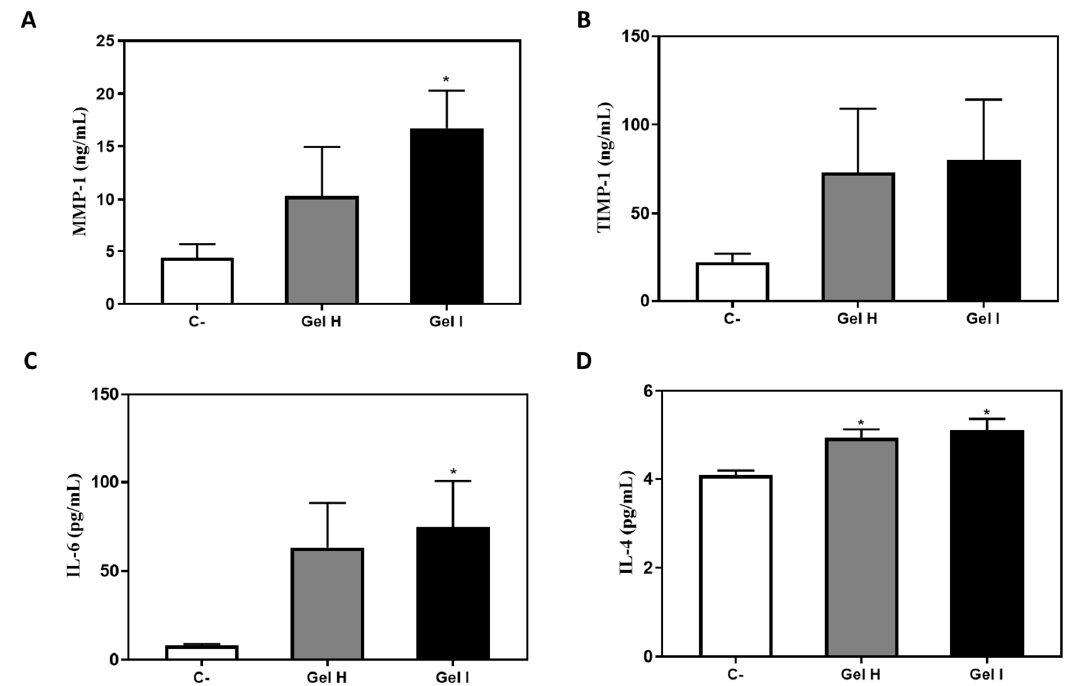
Figure 8. Effect of periodontal gels H and I on MMP-1 ( A ), TIMP-1 ( B ) IL-6 ( C ) and IL-4 ( D ) release by GTE 72 h after treatment and LPS stimulation. Negative control (C − ) was obtained from culture media of GTE treated with PBS. Values represent the mean ± SEM ( n = 6). Results were statistically compared by ANOVA and LSD as post hoc: * p < 0.05 treatment vs. negative